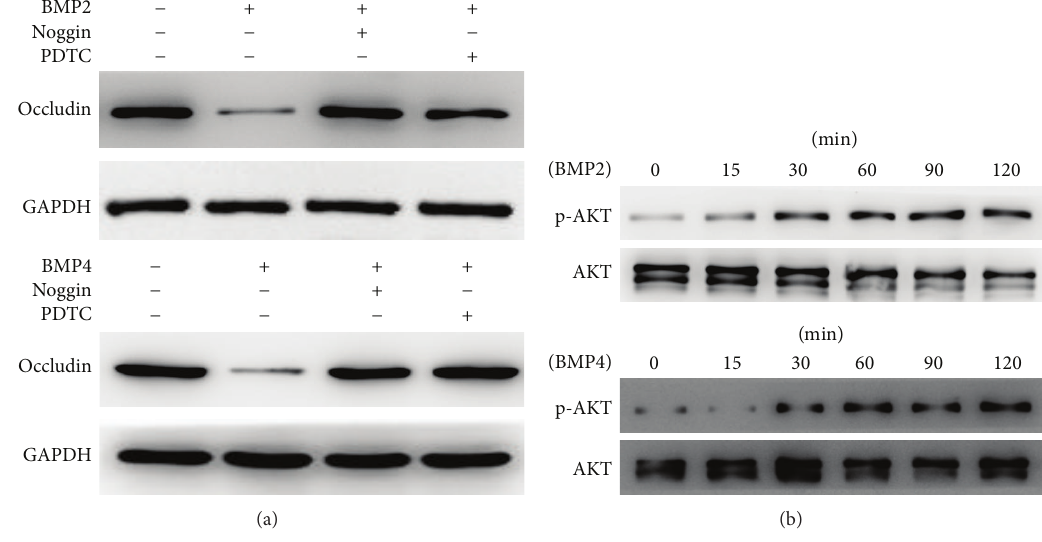
Figure 5: (a) Occludin protein expression was decreased in IEC-6 cells upon BMP2 or BMP4 treatment for 24 h, but both noggin and PDTC reversed the decrease in occludin expression in IEC-6 cells. (b) AKT phosphorylation progressively increased from 15min to 120 min with BMP2 or BMP4